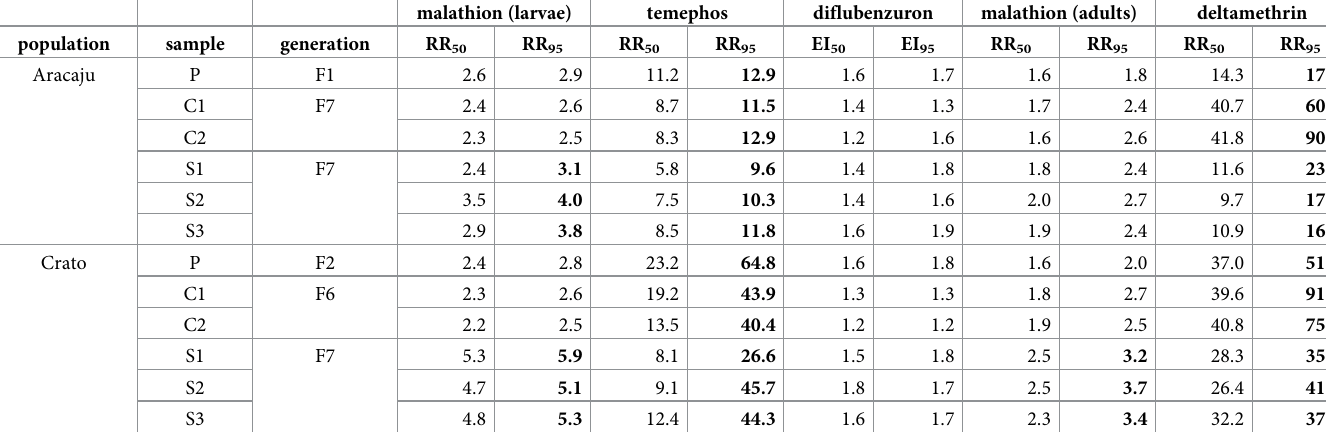
P: results of pre-selection populations, previously described by Viana-Medeiros et al. [29]; (C1, C2): samples kept in the laboratory, without insecticides; (S1-S3) samples after selection of larvae with malathion. In all cases, the classification criterion employed for temephos in Brazil was applied [43,15]: samples with RR 95 greater than 3.0 (shown in bold) are considered resistant. The Rockefeller strain was used as an insecticide susceptibility control. For effective doses and confidence intervals see S1–S5